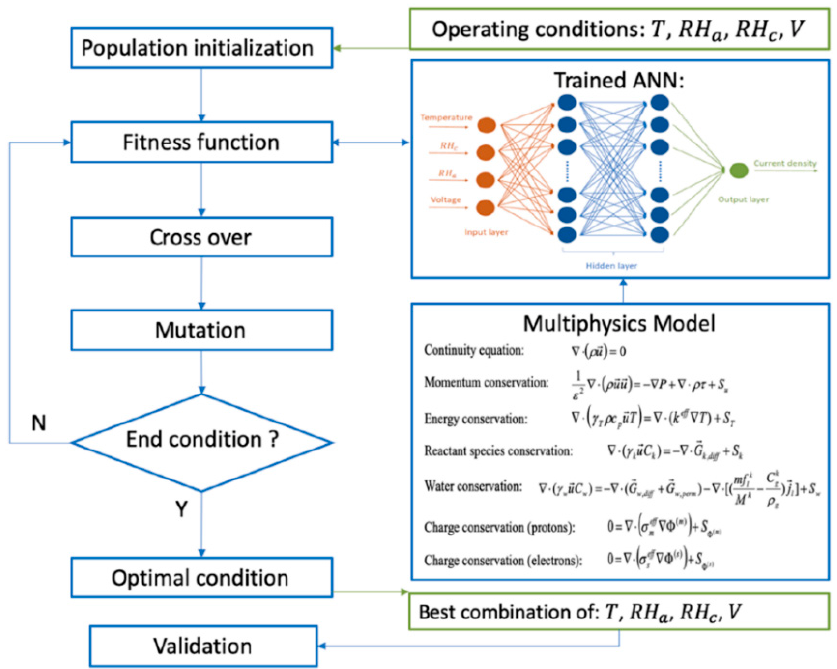
Figure 14. Optimization and control of PEM for maximum power by combined DL and 3D multiphysics simulation [109].